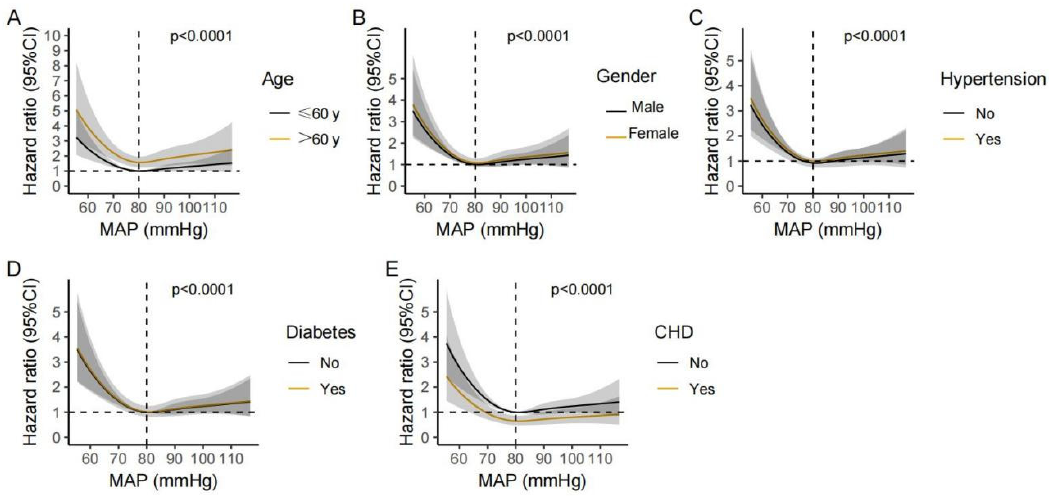
Figure 5. Non-linear association between MAP and the 7-day mortality of stroke patients in different subgroups. Hazard ratio and 95% CI were visualized using ribbons for following subgroups: age > 60 or ≤ 60 ( A ), male or female ( B ), with or without hypertension ( C ), with or without diabetes ( D ), and with or without CHD ( E ).